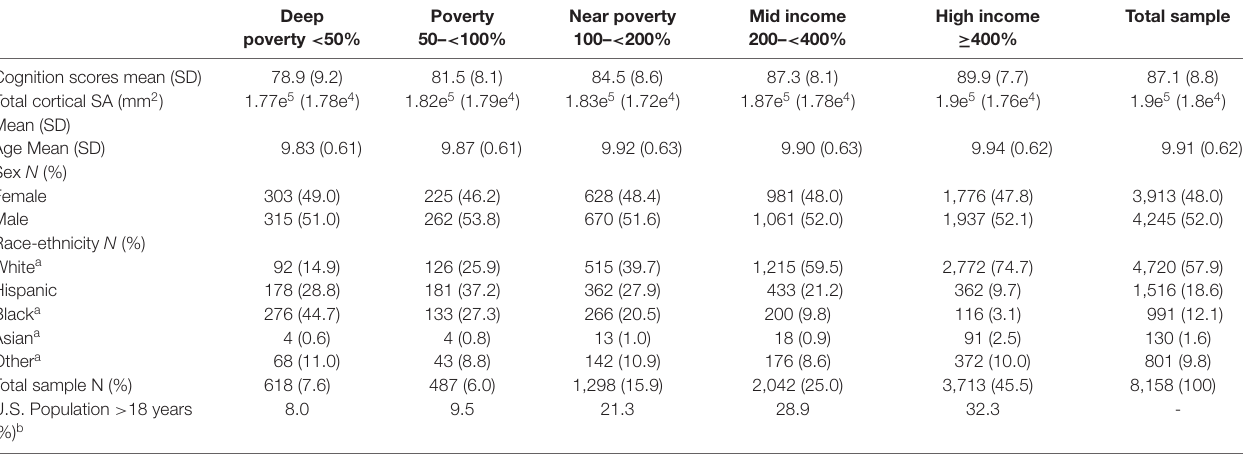
TABLE 1 | Distributions for cognition scores, total cortical surface area (SA), age, sex, and race-ethnicity are shown for the overall sample and each income-to-need group as defined by the federal poverty level.